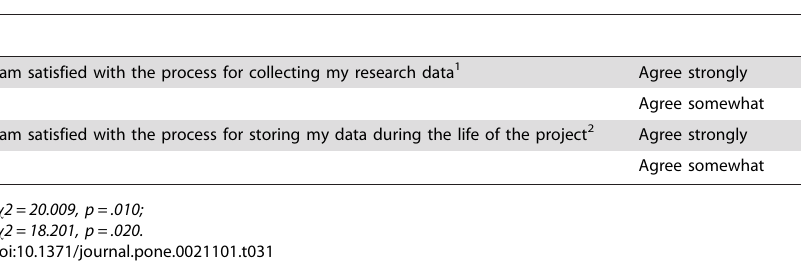
Table 31. Satisfaction by geographic location.